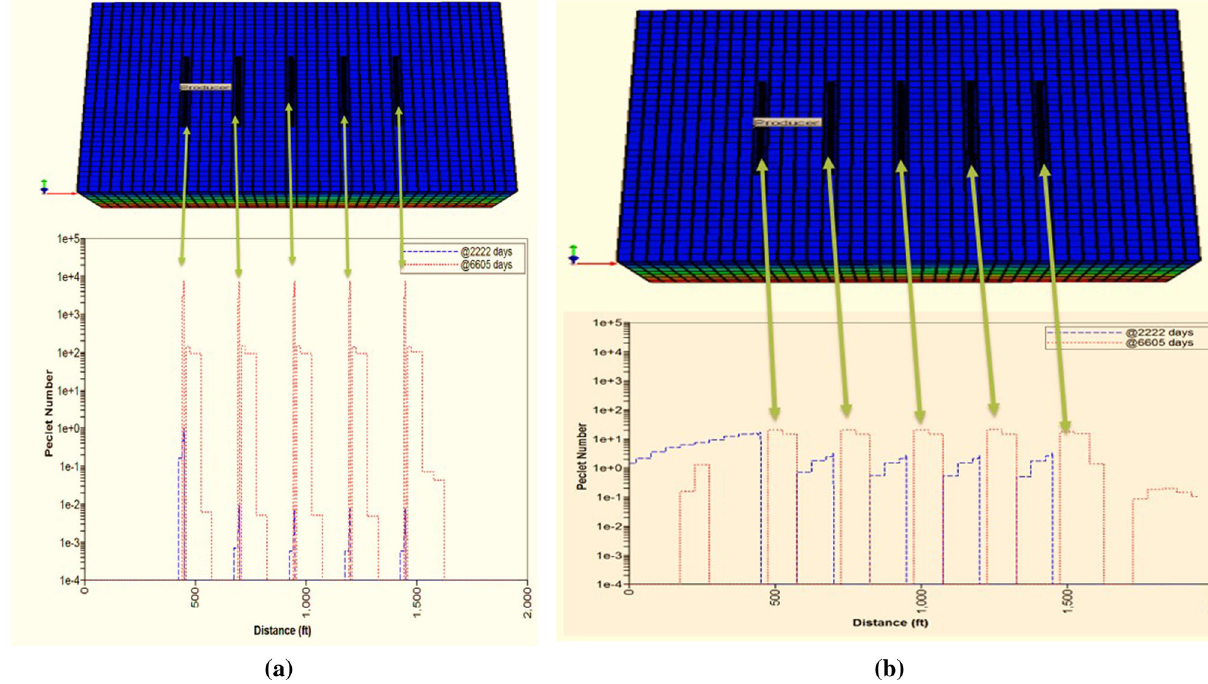
Fig. 8 Pe´clet number distribution: a long cross-section in the matrix model. a Gas phase. b Oil